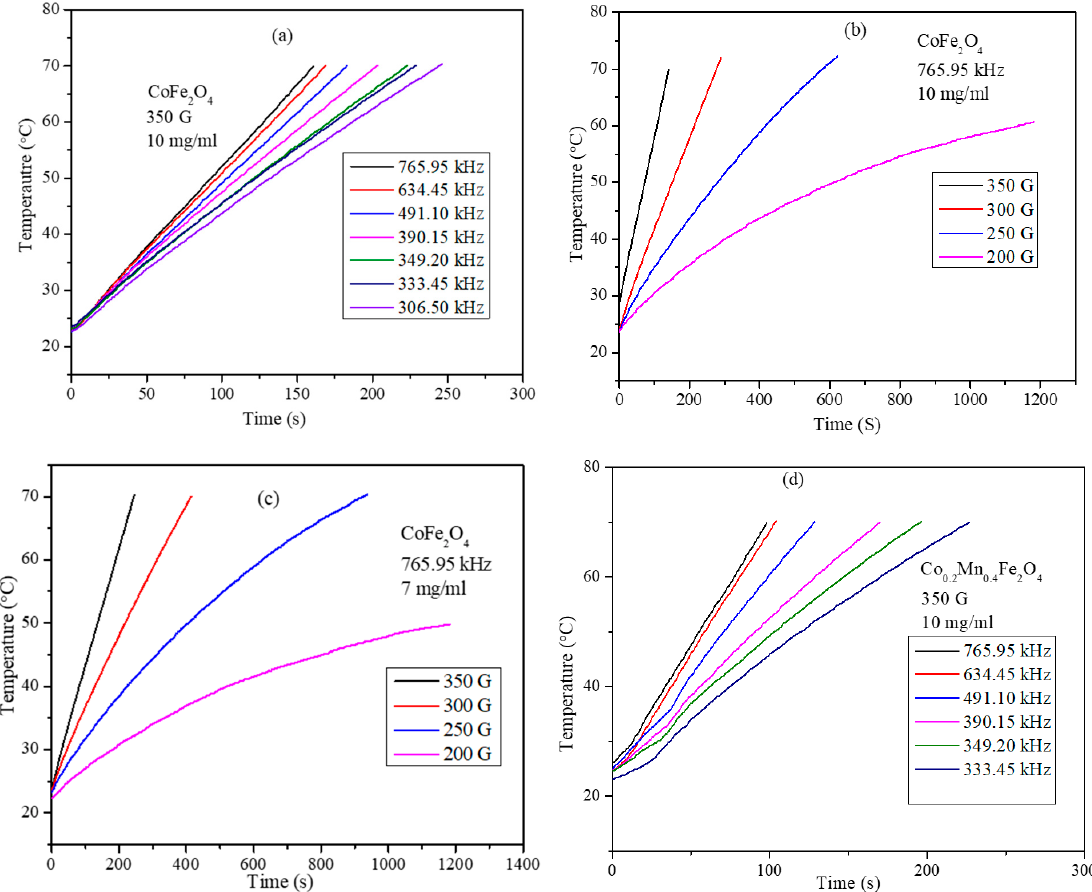
Figure 7. Heating profiles of PEG-coated CoFe 2 O 4 nanoparticles: ( a ) at 350 G for 10 mg/mL concentration, ( b ) at 765.95 kHz for 10 mg/mL concentration, ( c ) at 765.95 kHz for 7 mg/mL concentration, and ( d ) PEG-coated Co 0.2 Mn 0.8 Fe 2 O 4 at 350 G for 10 mg/mL concentration.